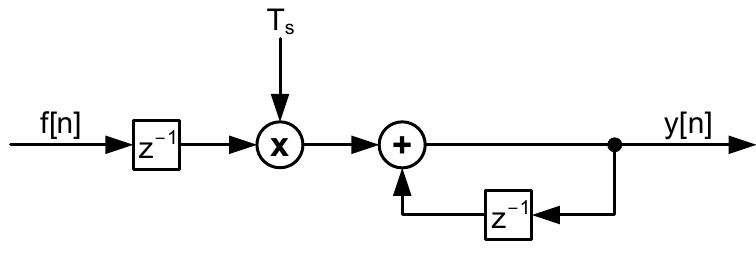
Figure 6. Block diagram form of integration approximation. Figure 7 improves the realization of Figure 6 by reducing one memory element.